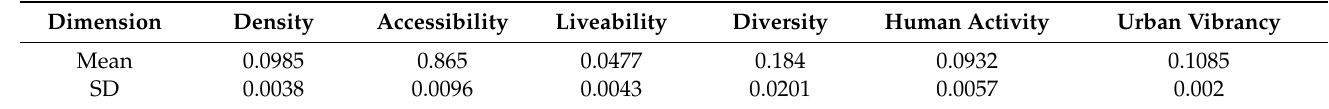
Table 2. Normalised values in different dimensions.